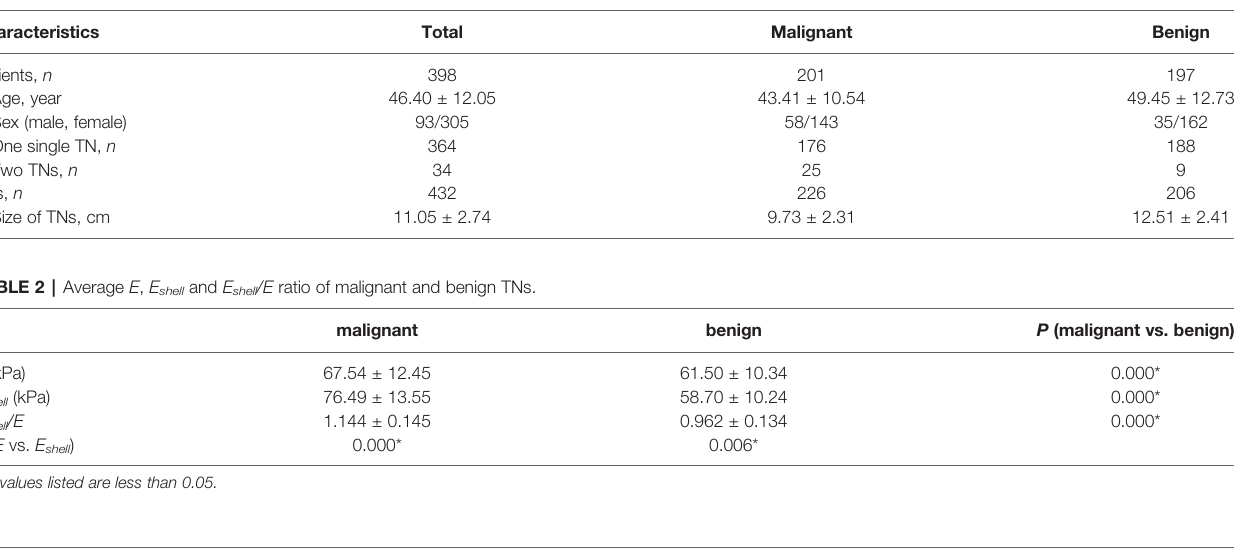
TABLE 1 | Characteristics of participants.